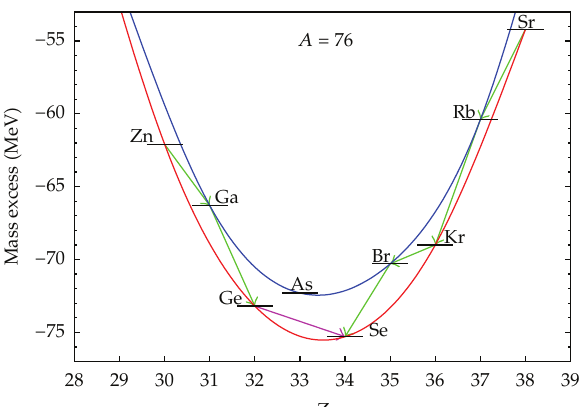
Figure 1: Representation of the energies of the A (cid:7) 76 isobars. The single-beta decay (cid:2) β (cid:3) —green arrows— between 76 Ge and 76 Se is energetically forbidden, hence leaving double beta (cid:2) ββ (cid:3) —pink arrow—as the only decay channel. The two mass parabolas exist because of the pairing interaction that lowers the energy of even Z —even N nuclei with respect to odd Z —odd N nuclei. For odd A nuclei there is a single mass parabola, and all single-beta transitions are energetically allowed (cid:2) taken from J. Menendez’s PhD thesis (cid:3)